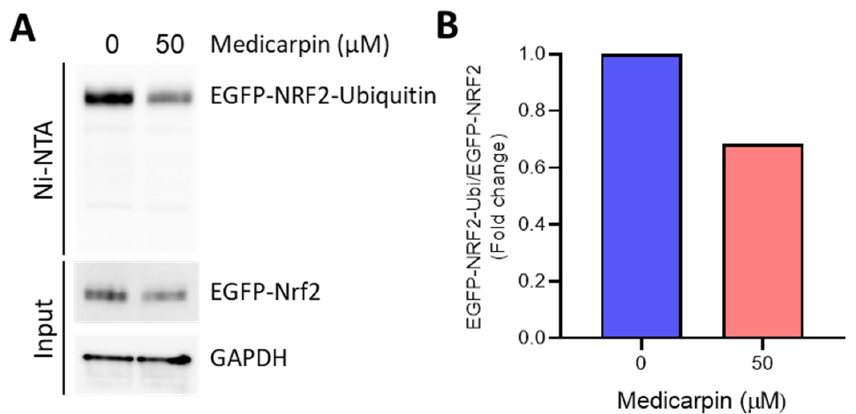
Figure 5. Medicarpin increases the NRF2 stability by inhibiting ubiquitin-mediated proteolysis in HeLa cells. ( A ). Cells were treated with 50 µM of medicarpin for 6 h after co-transfection with pEGFP-NRF2 and pcDNA3.1-His ubiquitin plasmids. Next, cells were lysed with RIPA and His-ubiquitinated proteins were purified using Ni-NTA agarose beads. After washing with RIPA, ubiquitinylated eGFP-NRF2 was visualized by Western blot analysis. ( B ). The relative fold change of ubiquitinylated eGFP-NRF2 was measured using a densitometer from ( A ). Experiments were performed in